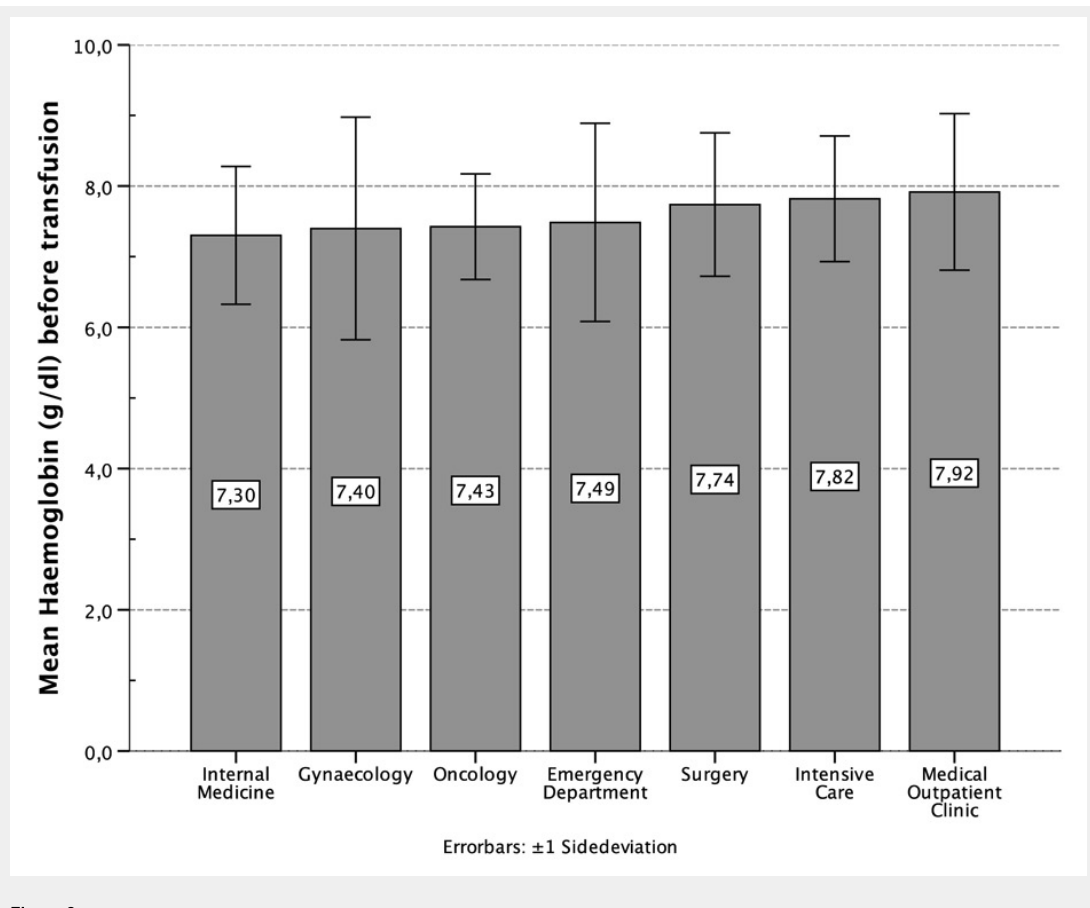
Figure 2 Mean haemoglobin (g/dl) before transfusion, distributed by